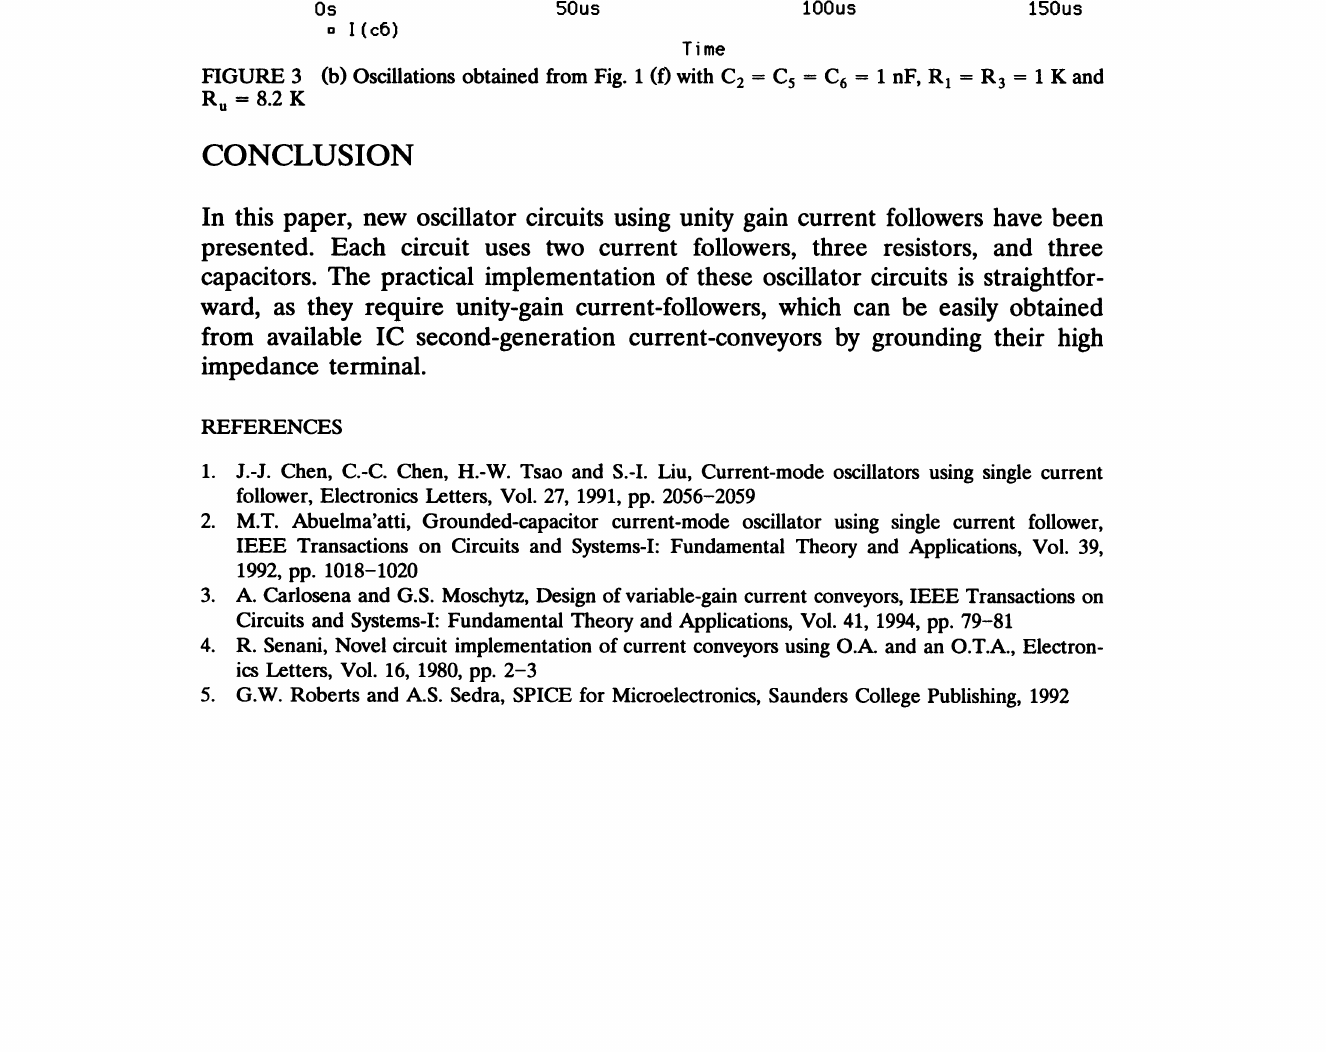
FIGURE 3 (b) Oscillations obtained from Fig. 1 (f) with